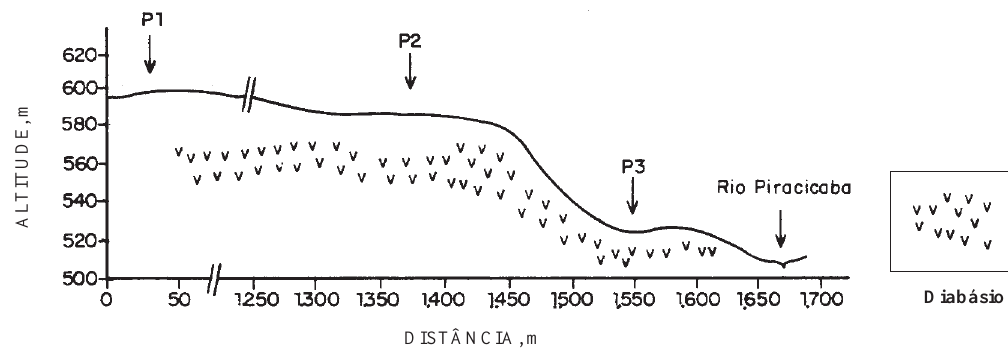
Figura 1. Posição relativa dos perfis (P) na toposseqüência onde foram obtidas as amostras do solo- controle e das estruturas biogênicas